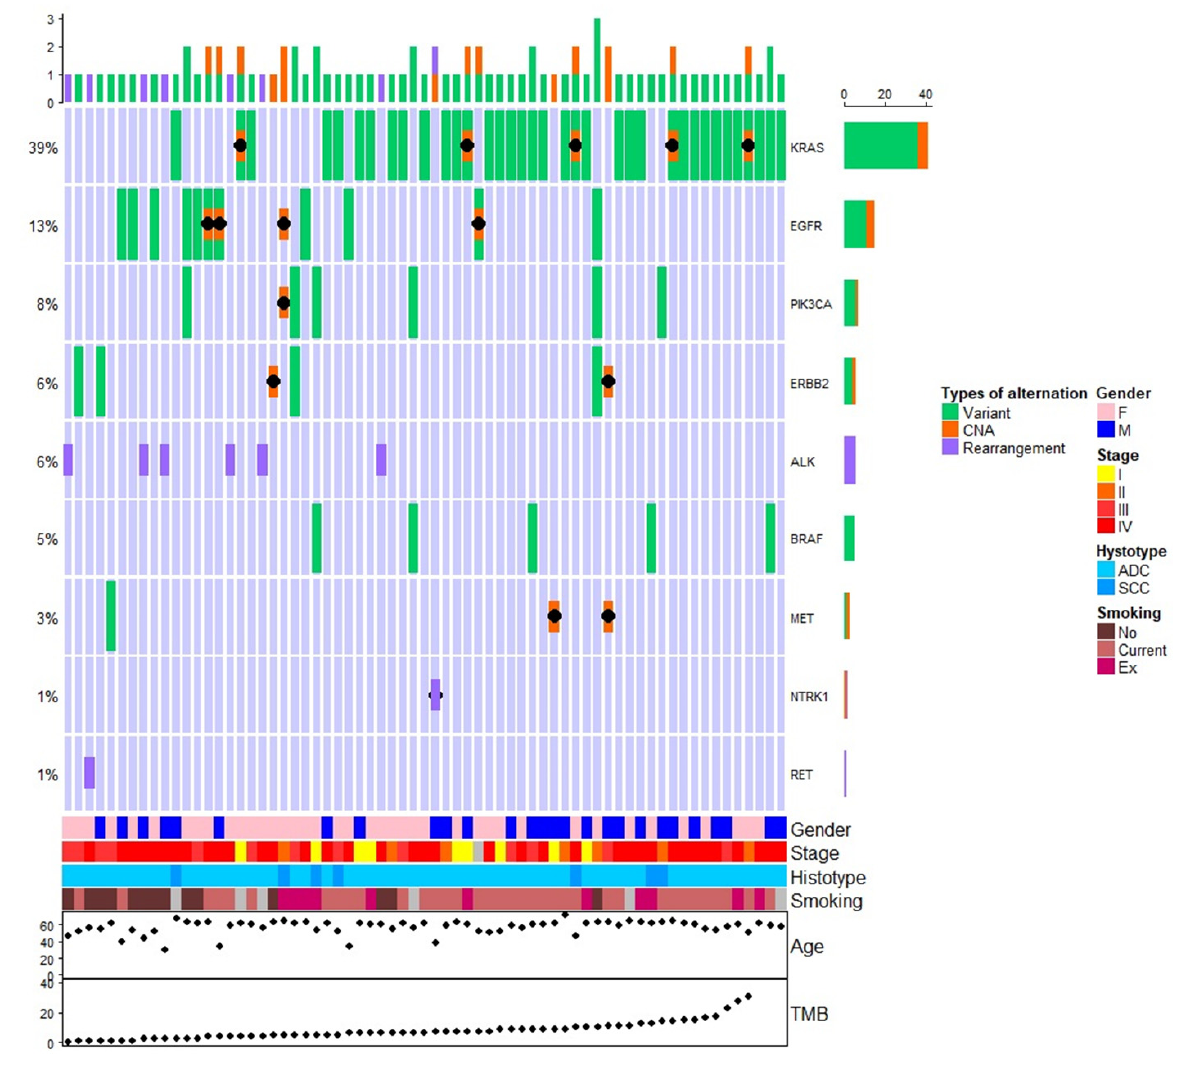
Figure 4. Oncoprint plot showing the distribution of targetable alterations and clinic-pathological patient’s characteristics ordered for TMB value (from lowest to highest value).